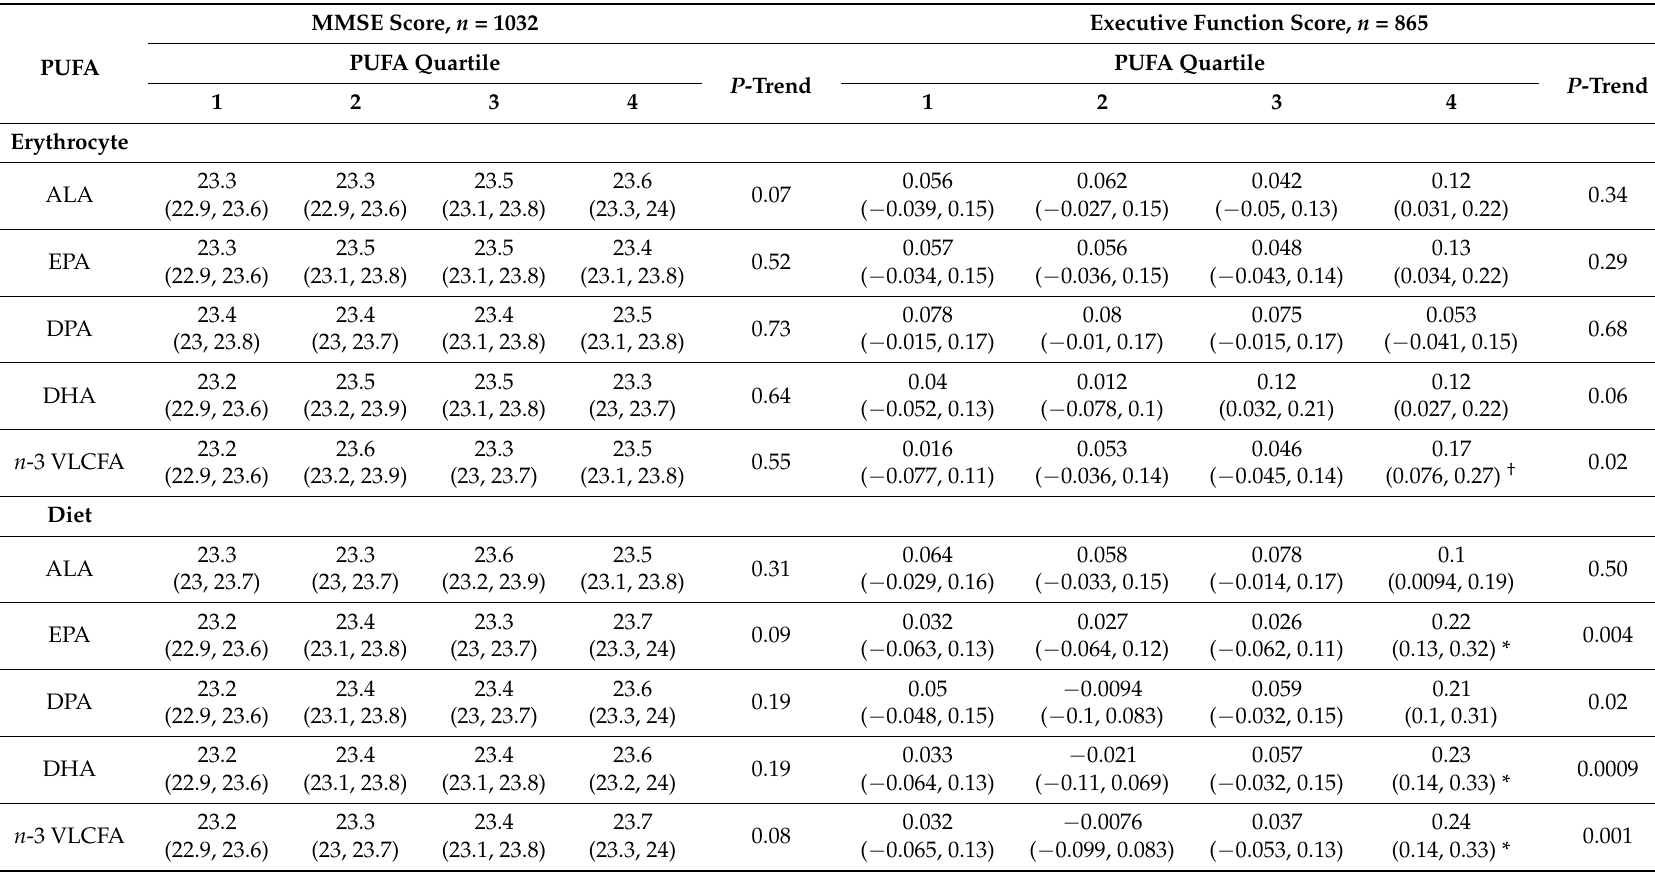
Table 2. Associations of baseline n -3 PUFA erythrocyte composition and dietary intake (quartiles) with 2-year executive function score, adjusted for baseline score a,b . MMSE Score, n = 1032 PUFA